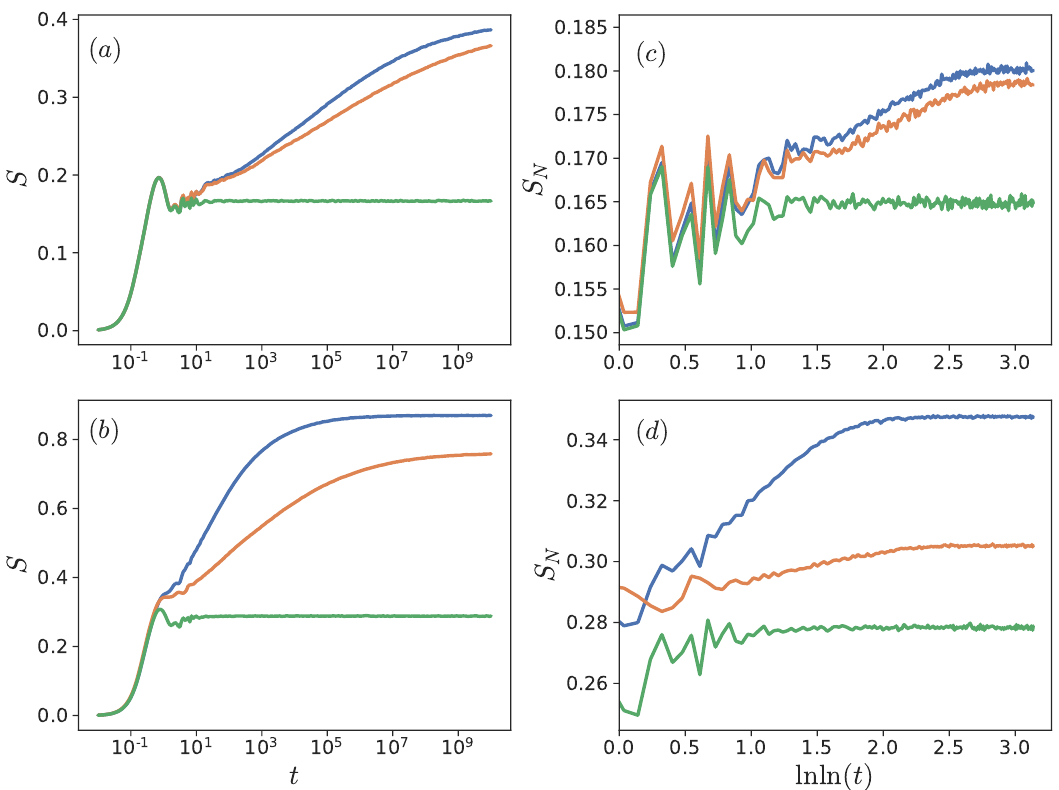
Figure 1: Results for L = 12 averaged over 80000 samples with D = 36 and V = 0.2 (top row) and D = 20 and V = 2.0 (bottom row). Left column (a, b): entanglement entropy, right column (c, d): number entropy. The largest entropies occur in the full model (blue) while the entropies quickly saturate in the Anderson case (green). The effective model is in between those two cases